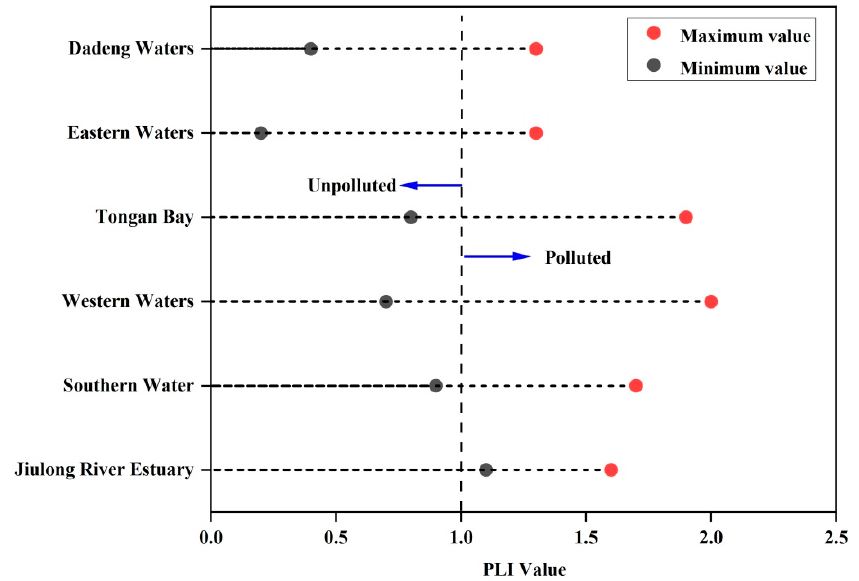
Figure 5. Lollipop chart of the pollution load index (PLI) in the subregions of Xiamen Bay. Table 2. The contamination factor (CF) and pollution load index (PLI) of the PTEs in the surface sediments of Xiamen Bay.